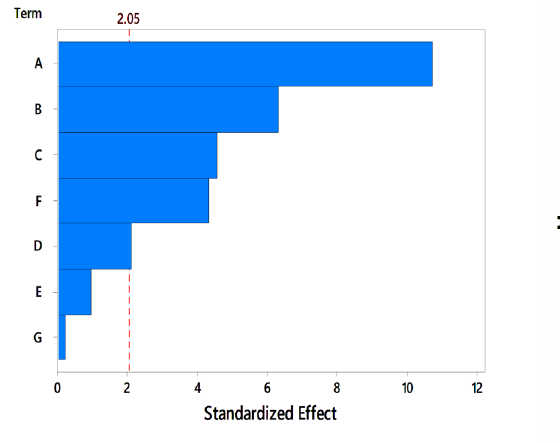
16 of 26 Table 10. The ANOVA table for the PB design of mineral salts. Source